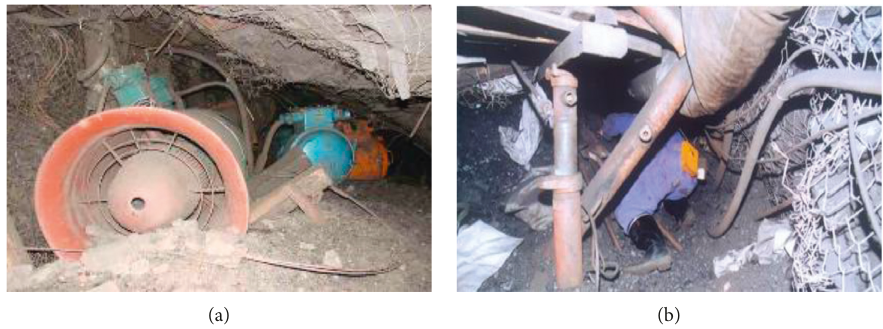
Figure 1: Field images of sites captured after accidents. (a) Devices being pulled down. (b) Support being pushed